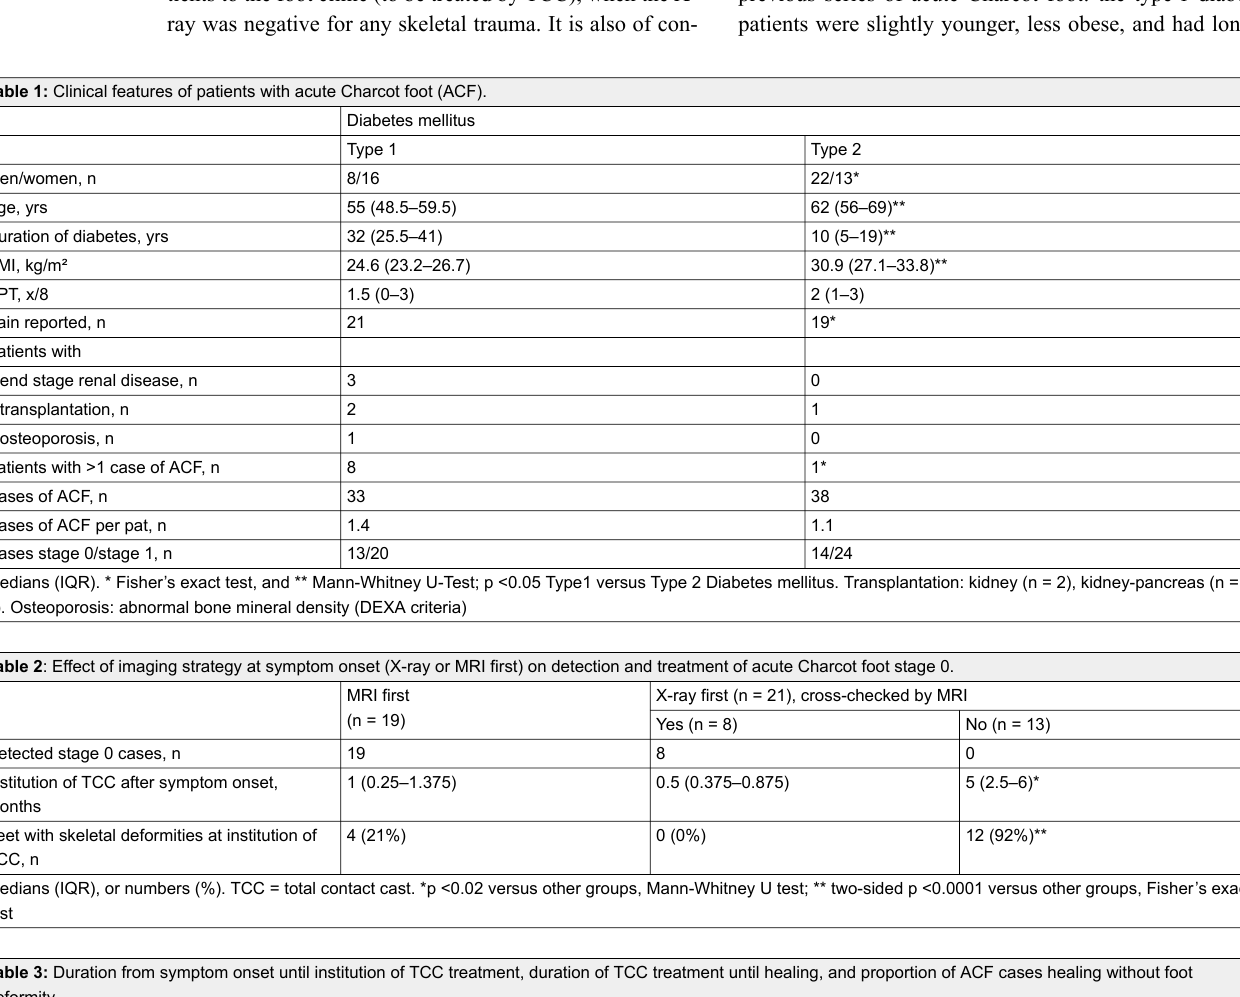
Table 3: Duration from symptom onset until institution of TCC treatment, duration of TCC treatment until healing, and proportion of ACF cases healing without foot deformity. Affected foot region